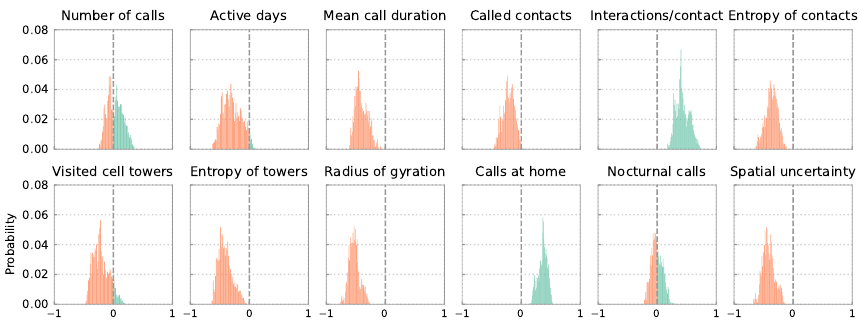
Figure 4. Distributions of the Spearman correlation coefficient for the relation between EDI and a selection of mobile phone indicators calculated for all 4914 city definitions. The histogram is colored green when correlation coefficients are positive and orange when